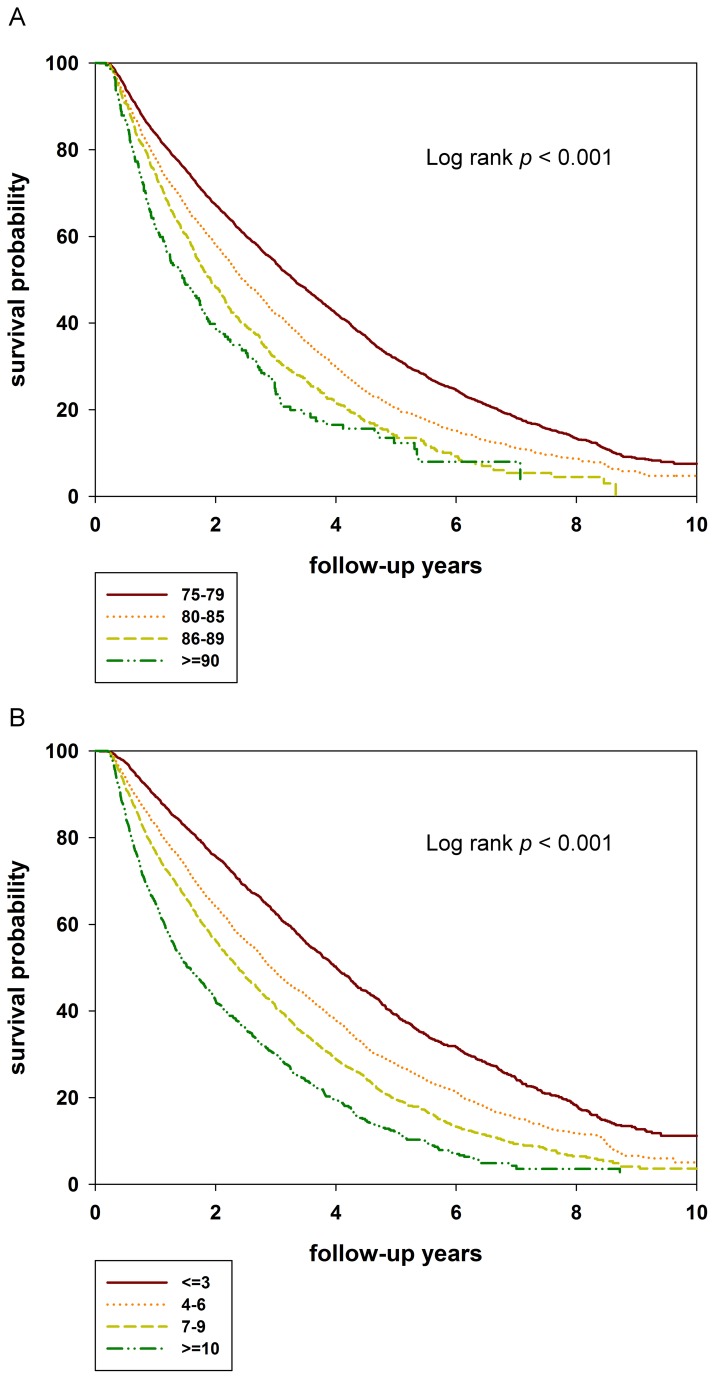
Survival curve stratified by age and Charlson comorbidity index (CCI) (A) Kaplan-Meier curves for 10 year survival by age.(B) Kaplan-Meier curves for 10 year survival by CCI. Survival calculations start 90 days after beginning dialysis. The survival rate of incident elderly hemodialysis patients declined as age and CCI increased.